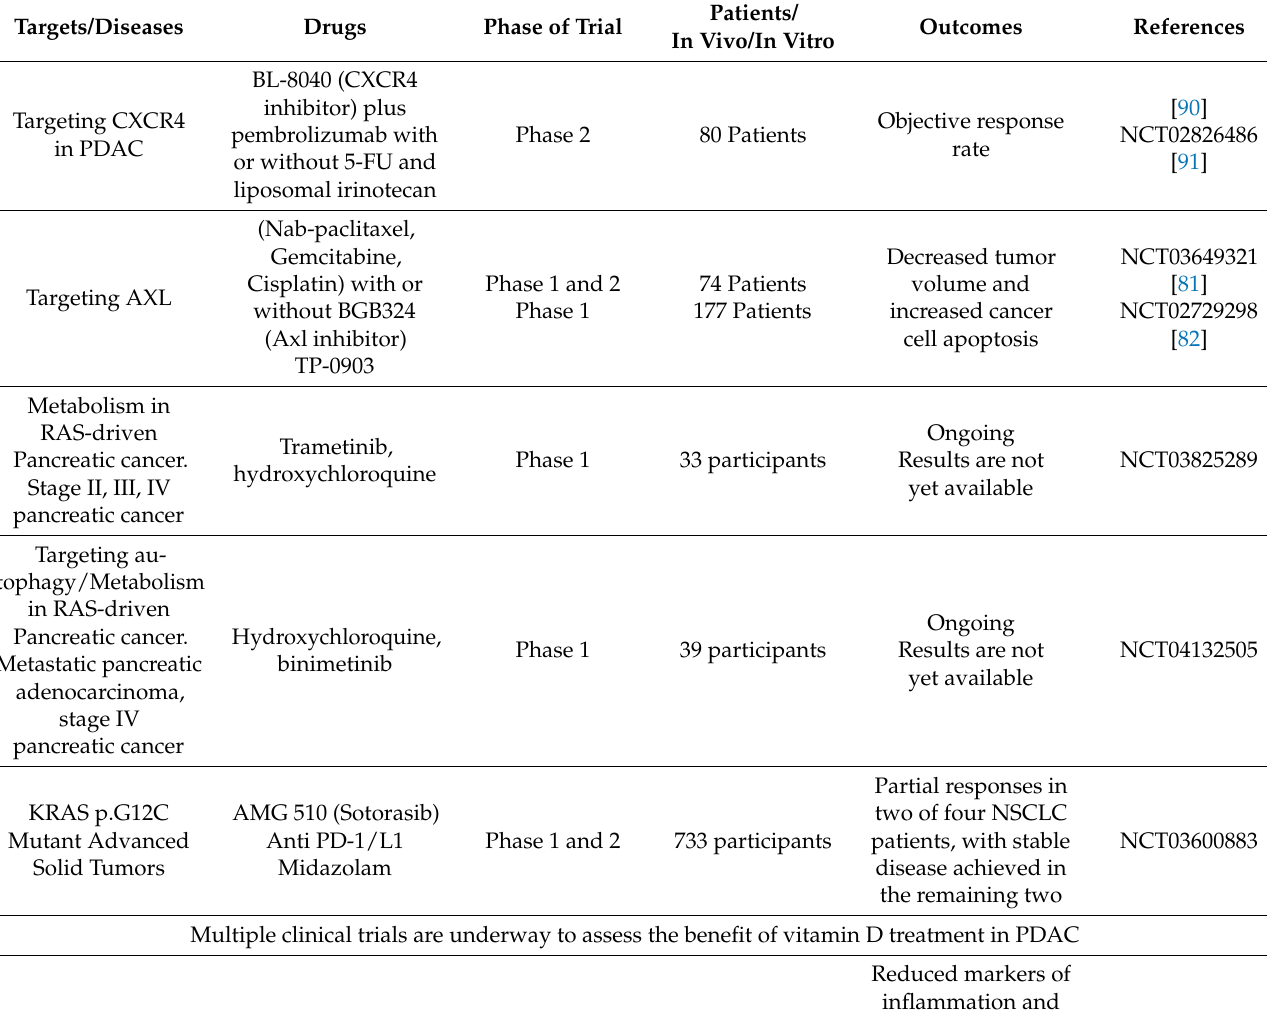
Table 1. Clinical trials of potential therapies targeting KRAS and its signaling pathways for the treatment of pancreatic ductal